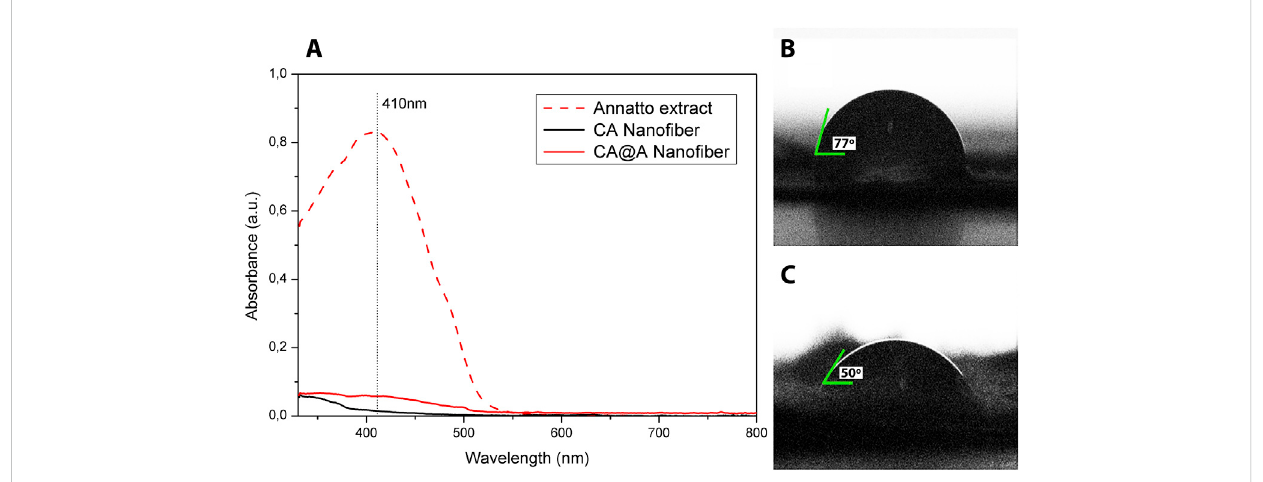
FIGURE 1 UV-absorption and water contact angle measurements. (A) UV-vis spectra of annatto extract, cellulose acetate nano fi bers (CA), and cellulose acetate nano fi bers with annatto extract (CA@A). Water contact angles of (B) cellulose acetate nano fi ber (CA) and (C) cellulose acetate nano fi ber impregnated with annatto extract